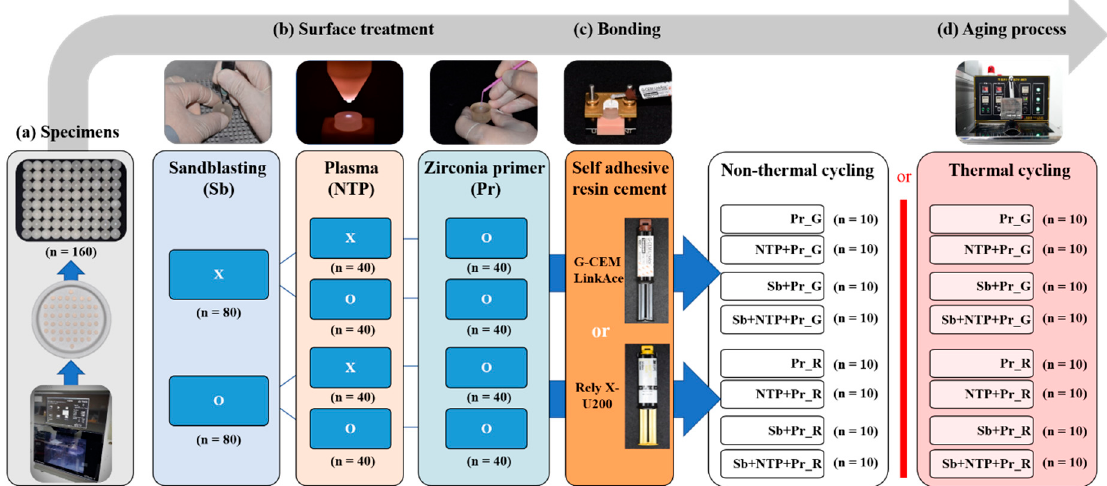
Figure 1. Specimens processing method and distribution flow for shear bond strength (SBS) experiment. ( a ) Fabrication of the disc type specimens ( b ) Surface treatment methods; ( c ) Bonding of Y-TZP surface and resin cement; ( d ) Thermal cycling process for aging.